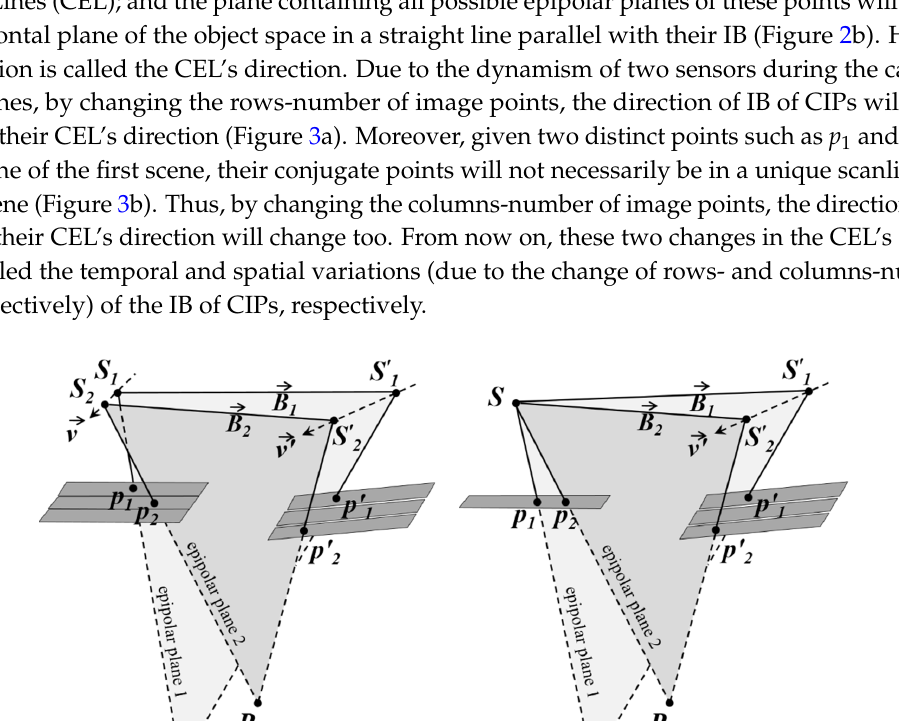
Figure 3. Variations in the direction of the IB of CIPs in the linear stereo scenes: ( a ) Temporal variations; ( b ) Spatial variations.